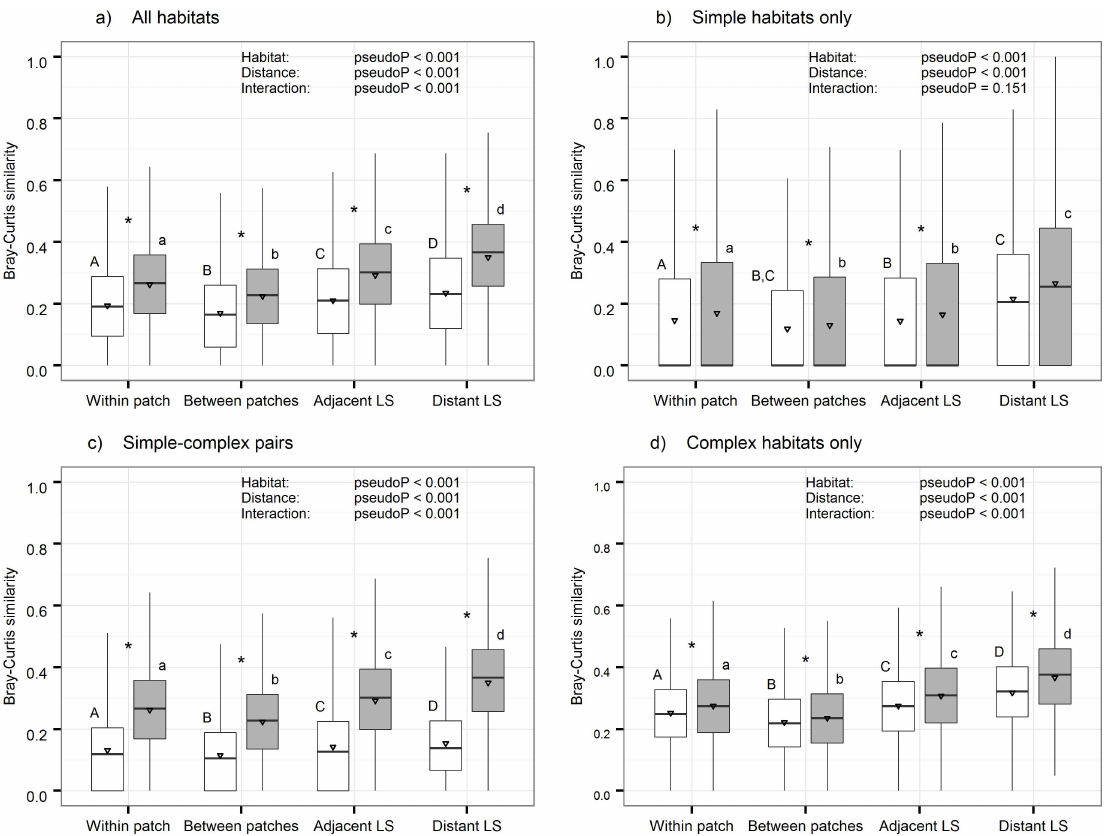
Fig 4. Results of the two-way non parametricMANOVA analyses. Median,25 and 75 percentiles( ± 1.5 inter quantilerange) and average(triangle)similarity in spidercommunity structure betweenpairs of samples. Pairs of samples are dividedto 4 distancecategories and 2 habitats categories—same habitat (white) or different habitats (grey). The panels representfour stratifications: (a) all habitats, (b) two samples from simple habitats, (c) one sample from a simple habitat and one from a complex habitat (d) two samples from complex habitat. In each panel,results of two-way non-parametric MANOVA are given. Distance categories that did not differ in the post-hoc are labelledwith a similar capital letters (same habitat) or lower-caseletters (different habitats). Within a distancecategory, significant differences betweensame habitat pairs and different habitats pairs are given as * .